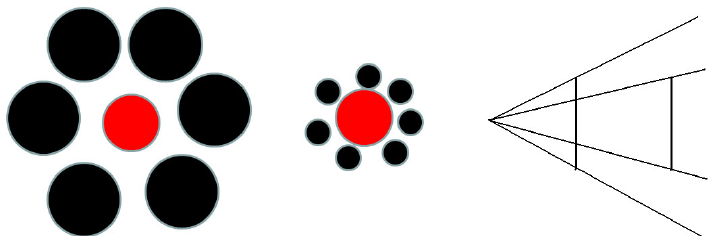
Fig. 2. The impact of sight adaptation on perception of size of symbols. Red circles of the same size appear to be larger or smaller depending on the size of surrounding black circles. The same phenomenon applies to the vertical lines surrounded by lines of different